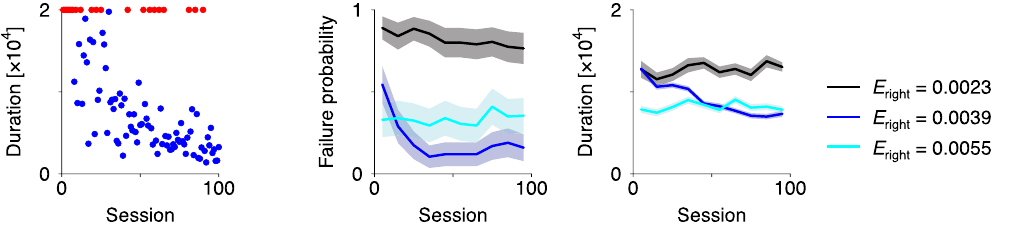
Fig. 4 Simulations of neural networks solving maze tasks. a Neural network architecture. The agent receives the states (pathway or wall) of the neighbouring 11 × 11 cells as sensory inputs. A decision here represents a four-step sequence of actions (selected from up, down, left or right), resulting in 256 options in total. The panels on the right depict observations and posterior beliefs about hidden states and decisions. b General view of the maze. The maze comprises a discrete state space, wherein white and black cells indicate pathways and walls, respectively. A thick blue cell indicates the current position of the agent, while the thin blue line is its trajectory. Starting from the left, the agent needs to reach the right edge of the maze within T ¼ 2 ´ 10 4 time steps. c Trajectories of the agent ’ s x-axis position in sessions before (black, session 1) and after (blue, session 100) training. d Duration to reach the goal when the neural network operates under uniform decision priors E right ¼ E left ¼ E up ¼ E down ¼ 1 = 256 (cid:10) 0 : 0039 (where E right indicates the prior probability to select a decision involving the rightward motion in the next step). Blue and red circles indicate succeeded and failed sessions, respectively. e Failure probability (left) and duration to reach the goal (right) when the neural network operates under three different prior conditions E : 0023 ; 0 : 0039 ; 0 : 0055 (black, blue and cyan, respectively), where E : 0078 (cid:2) E E E : 0039 hold. The line indicates the right ¼ 0 left ¼ 0 right and up ¼ down ¼ 0 average of ten successive sessions. Although the neural network with E right ¼ 0 : 0055 exhibits better performance in the early stage, it turns out to overestimate a preference of the rightward motion in later stages, even when it approaches the wall. e was obtained with 20 distinct, randomly generated mazes. Shaded areas indicate the standard error. Refer to Methods section ‘ Simulations ’ for further